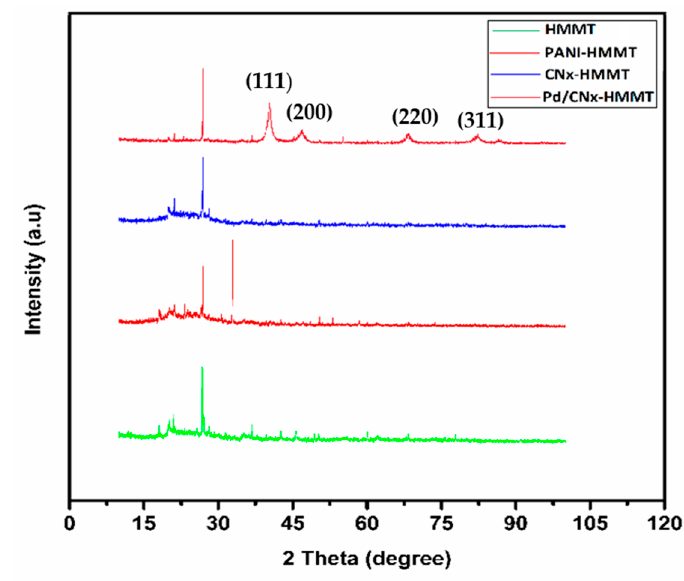
Figure 3. XRD patterns of HMMT, PANI–HMMT, CNx-HMMT, and Pd/CNx-HMMT.